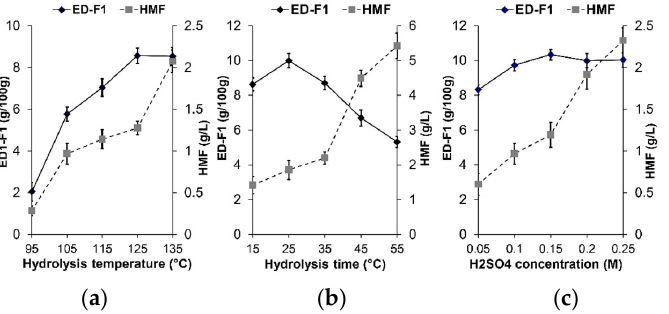
Figure 3. The yield of ED ‐ F1 fraction and HMF by ‐ product as affected by ( a ) hydrolysis temperature, ( b ) hydrolysis time and ( c ) H 2 SO 4 concentration. ( b ) hydrolysis time and ( c ) H 2 SO 4